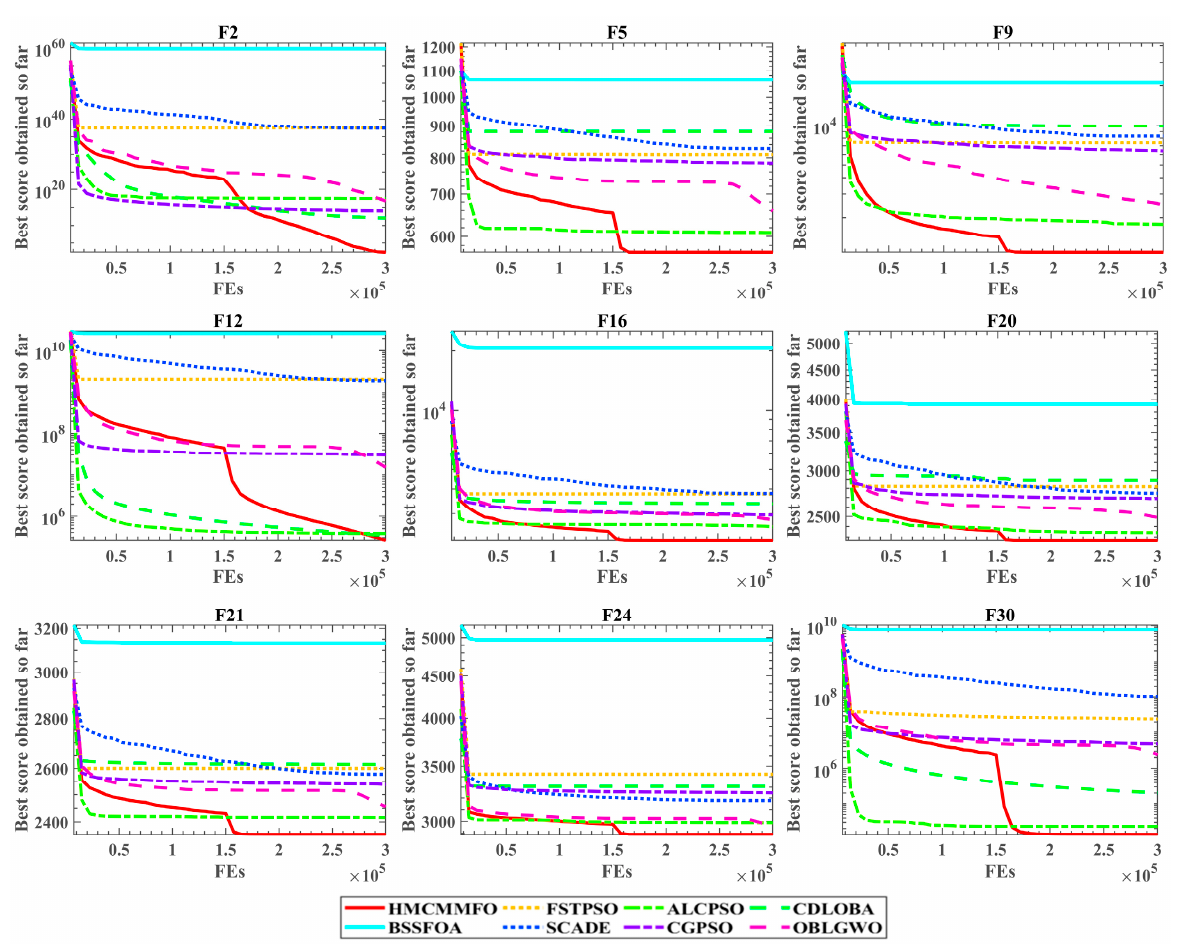
Figure 6. Convergence effect of advanced algorithms.